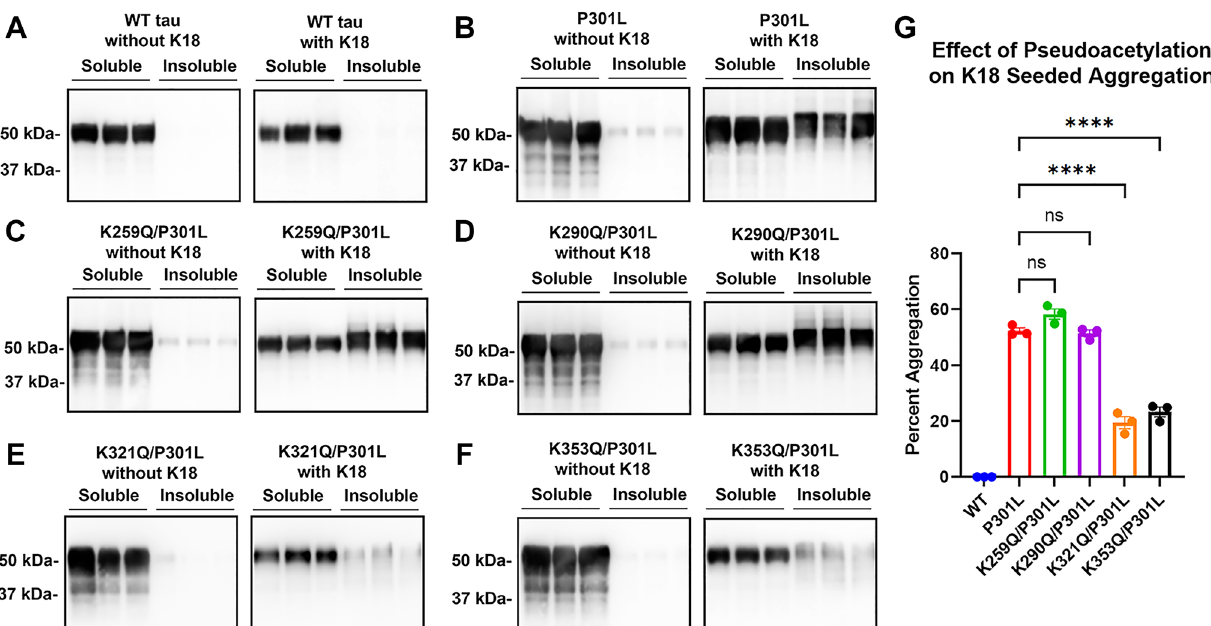
Figure 4. K321Q and K353Q tau acetylmimetics inhibit prion-like seeded aggregation in the context of P301L mutation. Cell-based tau inclusion assays were used to determine aggregation and prion-like seeding of ( A ) 0N4R WT tau, and ( B ) P301L, ( C ) K259Q/P301L, ( D ) K290Q/P301L, ( E ) K321Q/P301L/, and ( F ) K353Q/ P301L 0N4R tau. Immunoblots were probed with tau antibody 3026. The relative molecular weight markers are shown on the left. ( G ) One-way ANOVA with Dunnett’s test was performed with N = 3 for WT tau and all mutations. ****p < 0.0001 and ns not statistically